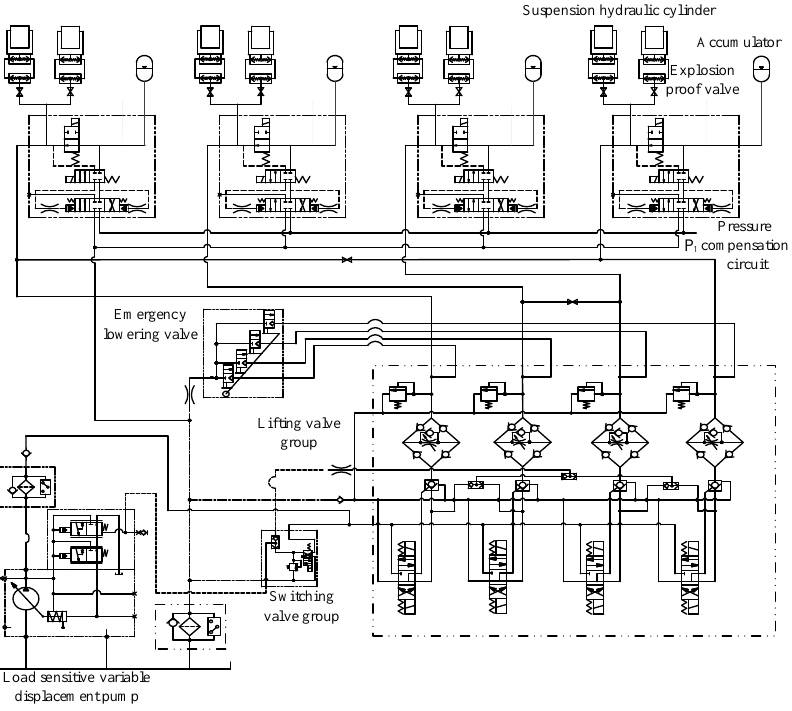
Figure 6. The schematic diagram of the improved suspension hydraulic system.